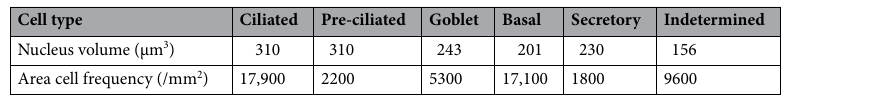
Table 1. Nominal nucleus sizes and frequencies of six cell types in the bronchial epithelium 22